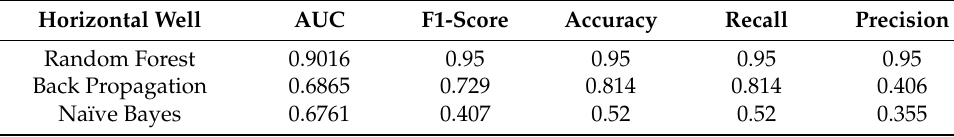
Table 2. Comparison of accuracy of three methods with direct well data.